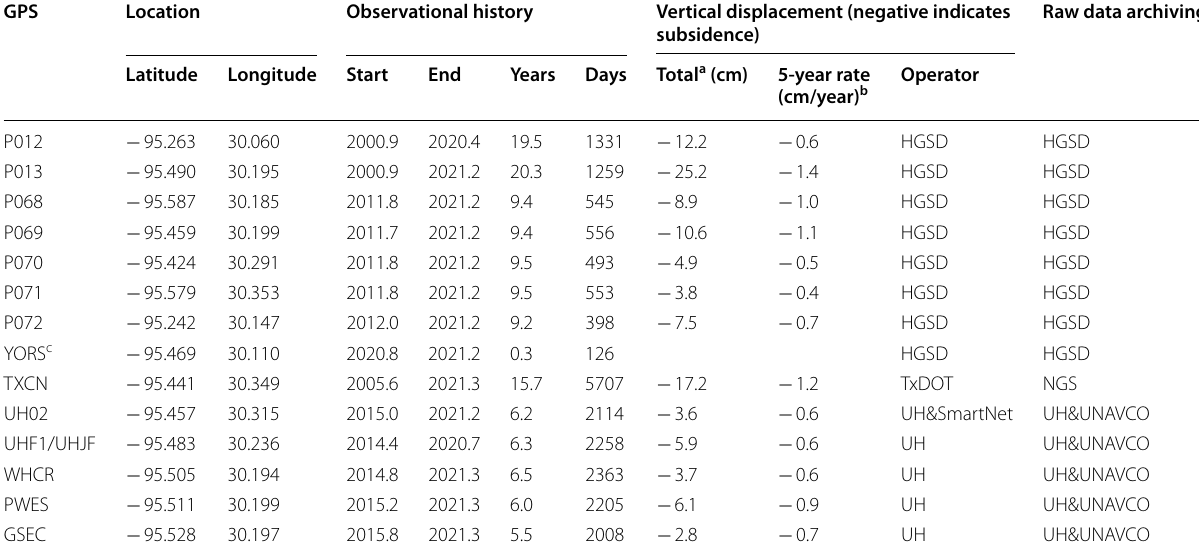
a Total subsidence represents the total vertical displacement over the entire history of each GPS station b The 5-year subsidence rate represents the linear trend of the subsidence time series from 2016 to 2020 c YORS is a new station installed in 2020. http:// www. twdb. texas. gov/ water plann ing/ water usesu rvey/ estim ates/ index.